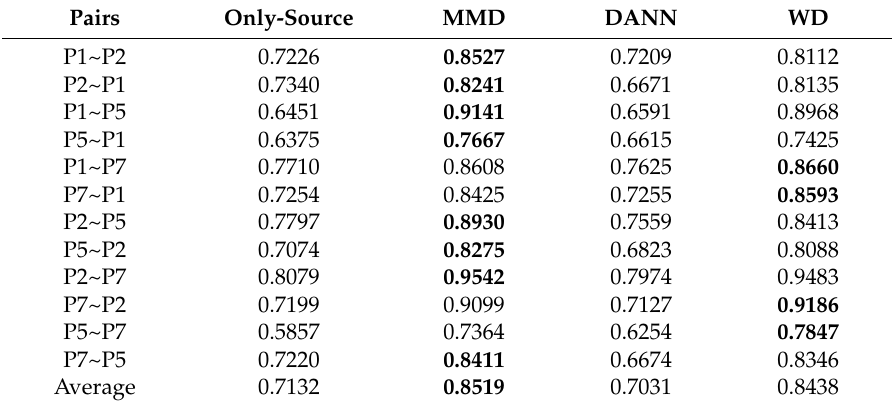
Table 5. The second round of experiment results of UCI. In this round of experiments, we reduced the amount of Target unlabeled data for training transfer to 1/3 and increased the test set to 2/3. The bold number is the best result for the experiments in the same